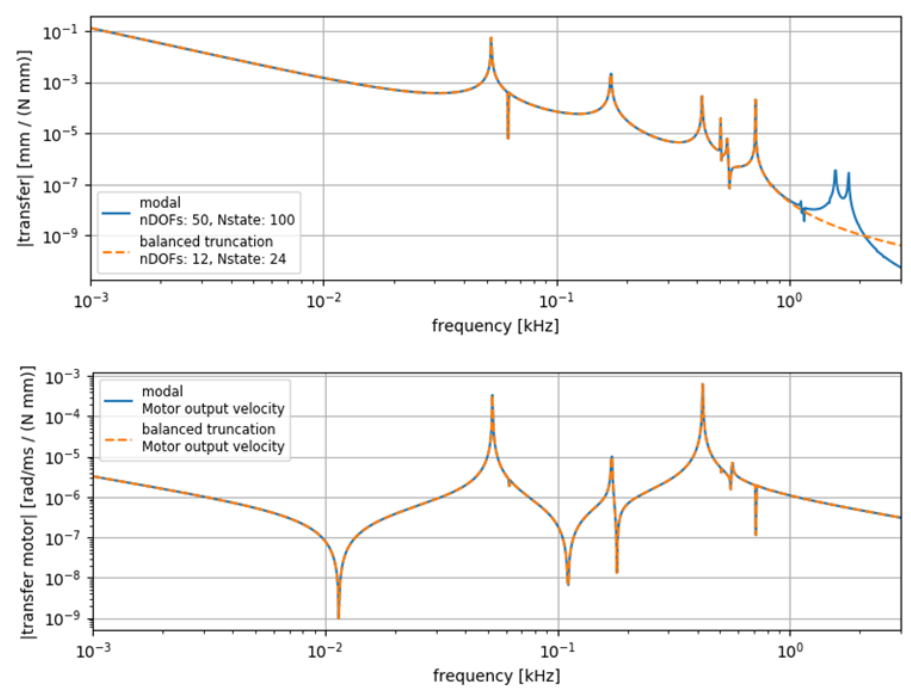
Figure 12. Transfer functions of the reduced model: tip displacement/motor torque ( top ), motor angular velocity/motor torque ( bottom